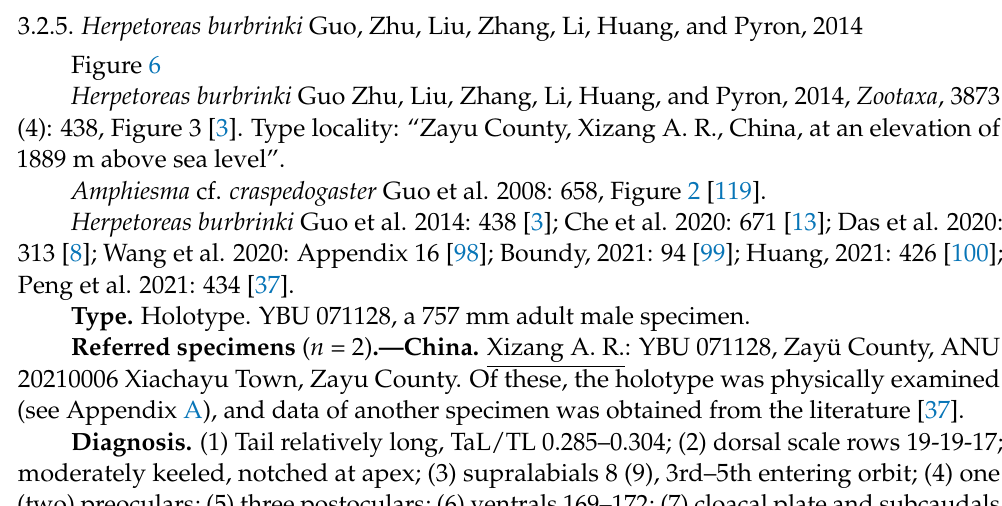
(4): 438, Figure 3 [3]. Type locality: “Zayu County, Xizang A. R., China, at an elevation